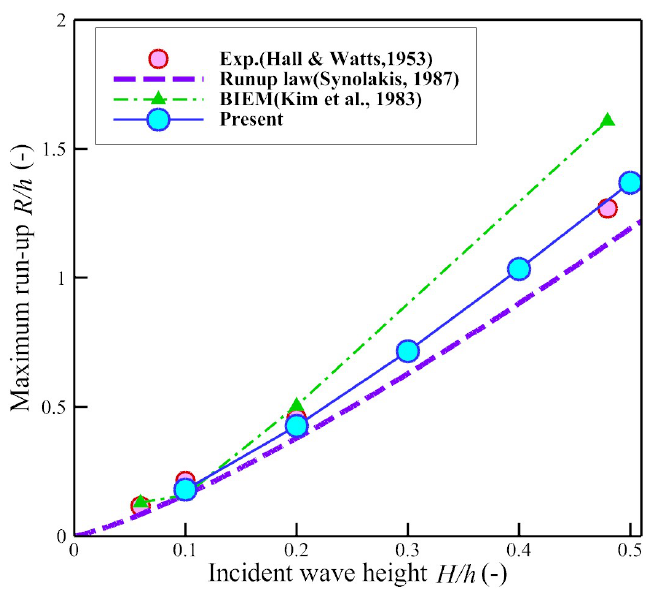
Figure 10. Comparison of the maximum run-up (constant slope angle = 45°).